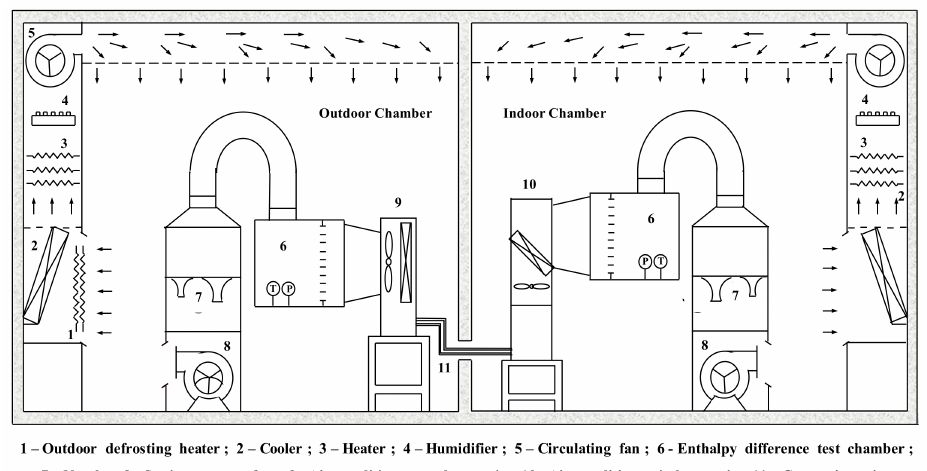
Figure 2. System diagram of the test equipment in enthalpy difference laboratory (“outdoor chamber” represents “chamber for testing outdoor unit”, and “indoor chamber” represents “chamber for testing indoor